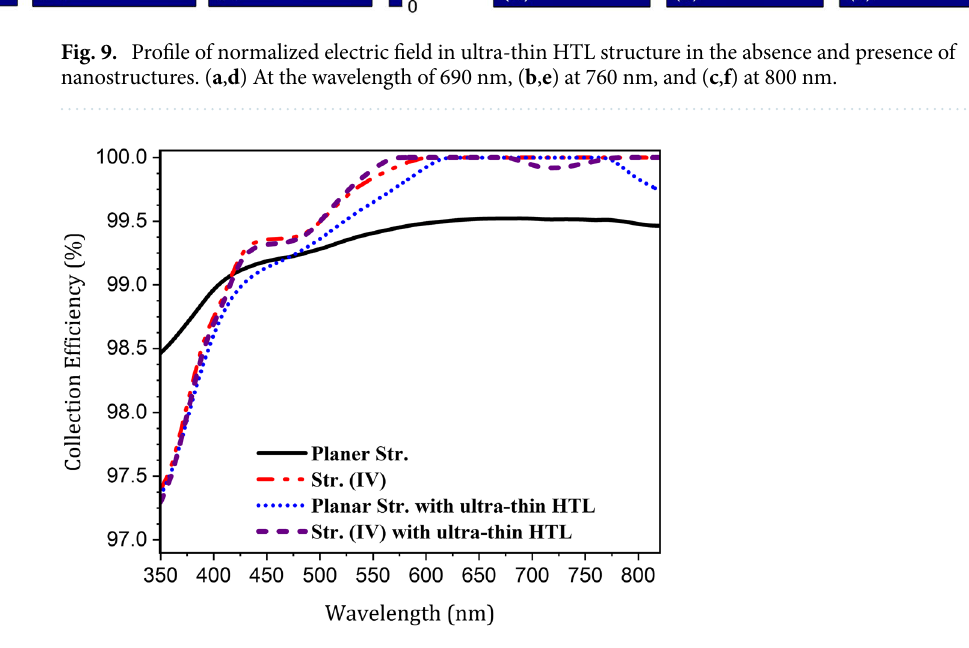
Fig. 10. The collection efficiency spectrum of the planar and proposed nanostrcutures of